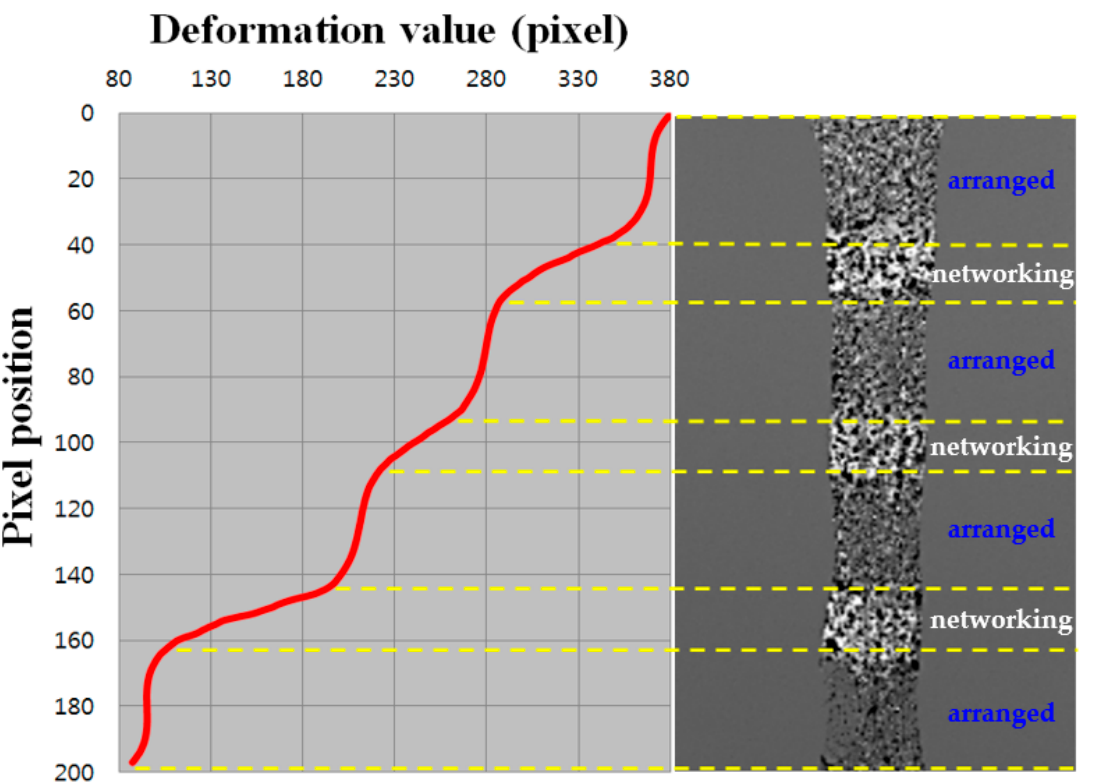
Figure 16. The displacement profile in the y-direction ( left ) and original image ( right ) at 400th image: random network part (white) and arranged part (dark) on the right. Figure 17. Separated regions are obvious by the repeated pattern of the random–uniform arrangement of